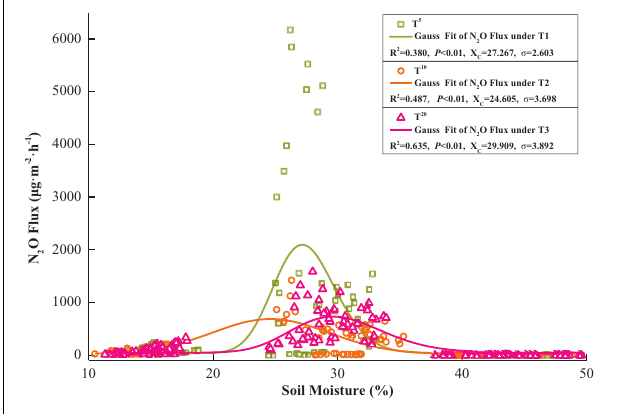
level of moisture is more likely to promote N 2 O emissions. In